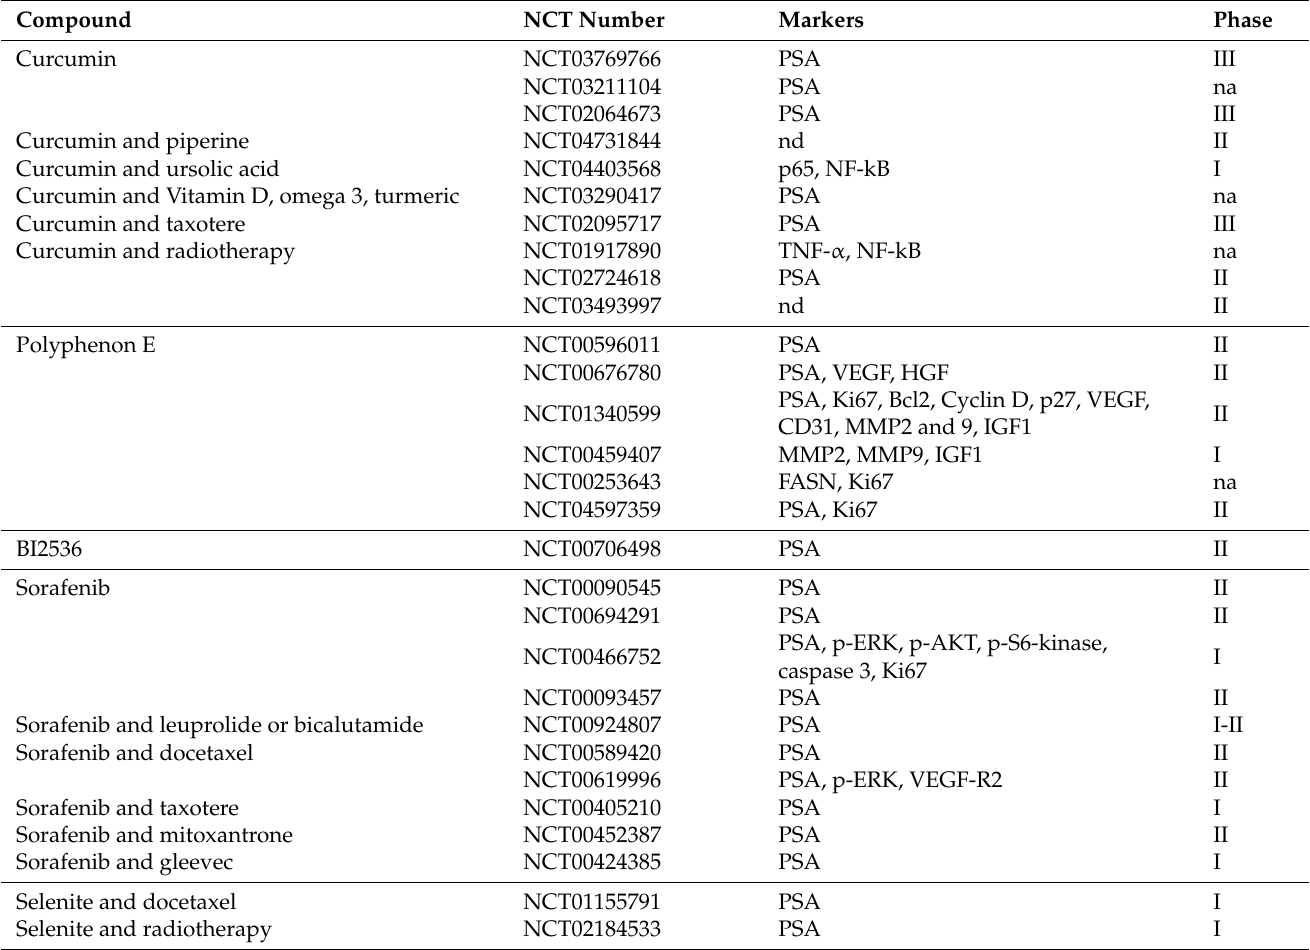
Table 3. Clinical trials containing necroptosis inducers ongoing in prostate cancer a